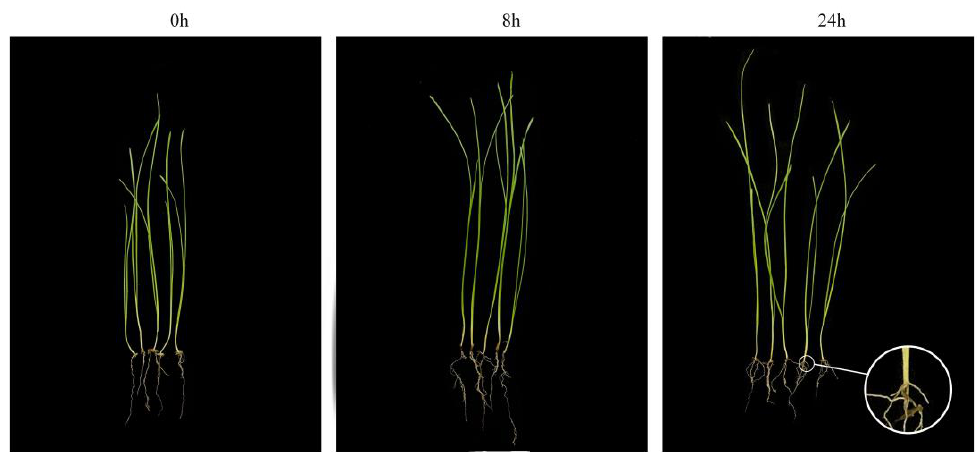
Figure 1. Effect of different duration of submergence stress on the morphology of orchardgrass.